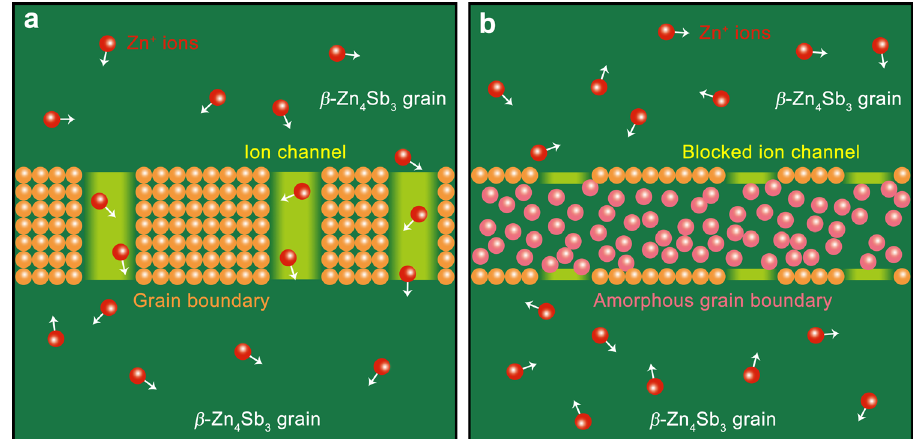
Fig. 5 Ion blocking mechanism. a Ion channels run through the grains to form a network all over the MQ + SPS Zn 4 Sb 3 bulk material. b Ion channels in EFAS Zn 4 Sb 3 bulk material are limited to the interior of the grain, and the amorphous layer on the grain boundary (including rich Zn and poor Zn) blocks the formation of the network due to the lack of